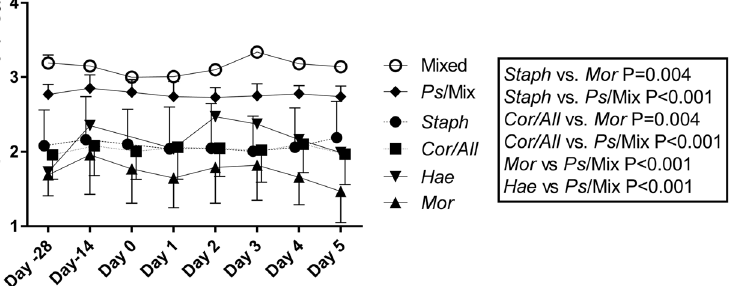
Figure 4. Mean alpha diversities of the clusters over time. Staph vs. Ps /Mix estimated mean difference (EMD) [log] = − 0.35, Cor/All vs. Ps /Mix EMD [log] = − 0.35, Mor vs. Ps /Mix EMD [log] = − 0.54, Hae vs. Ps /Mix EMD [log] = − 0.37, Staph vs. Mor EMD [log] = 0.19, and Cor/All vs. Mor EMD [log] = 0.19. RM ANCOVA, all p-values are unadjusted. Over time total N: Mixed N = 11, Ps /Mix N = 110, Staph N = 288, Cor/All N = 429, Hae N = 25, and Mor N =